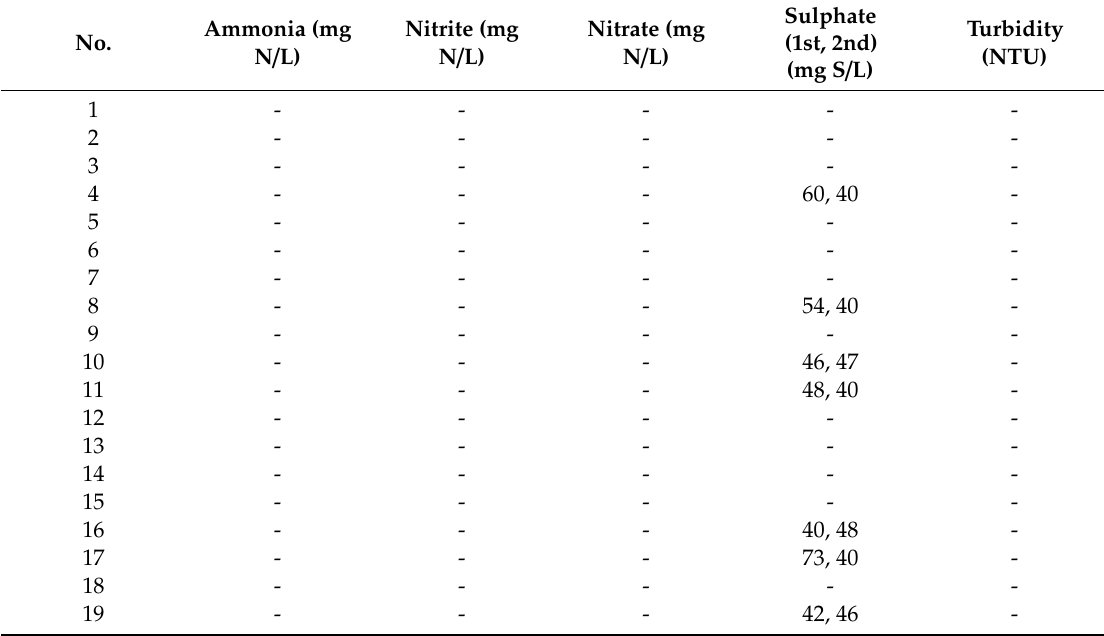
Table 6. Ammonia, nitrate, nitrite, sulphate and turbidity from Kampala water distribution systems. Ammonia, nitrate and sulphate are shown in one item as they were not detected (or not found to be below measurable limits by the photometer) in two different measurements; these are indicated with a dash. The name of the numbered sites is as shown in Table 1.